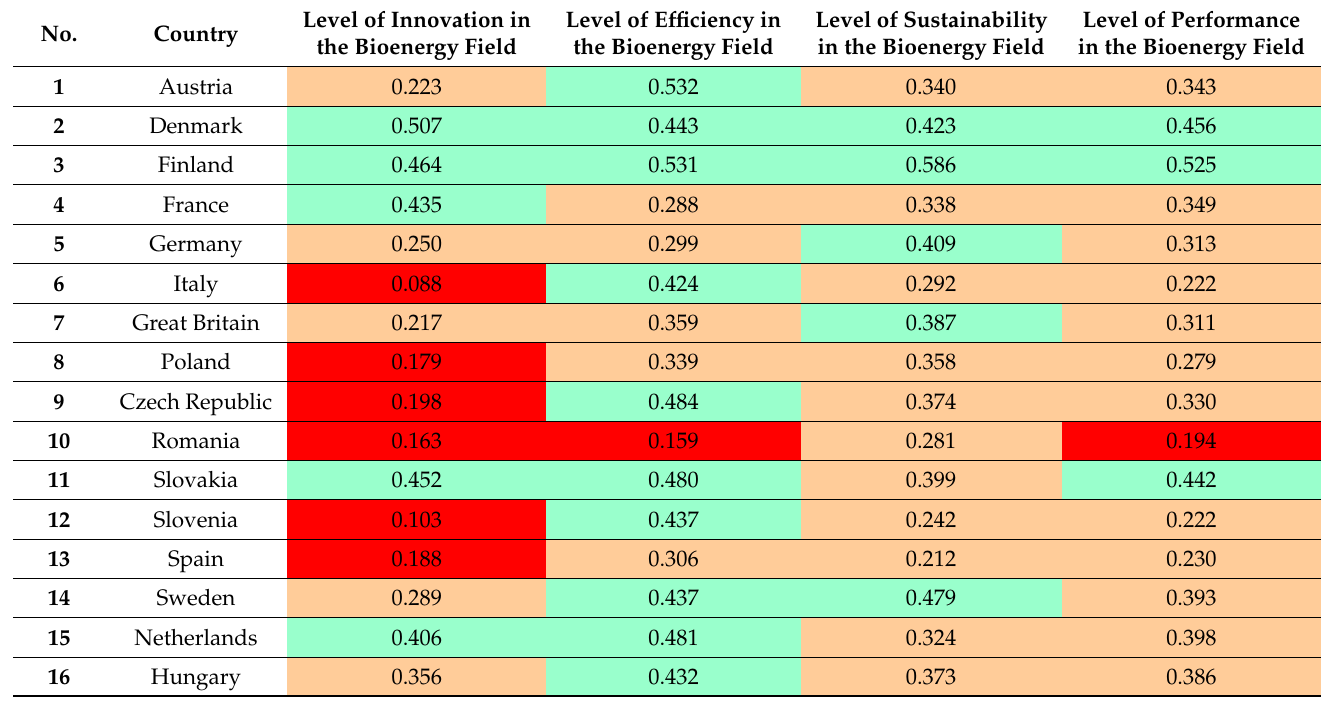
Table 6. Summary of results.